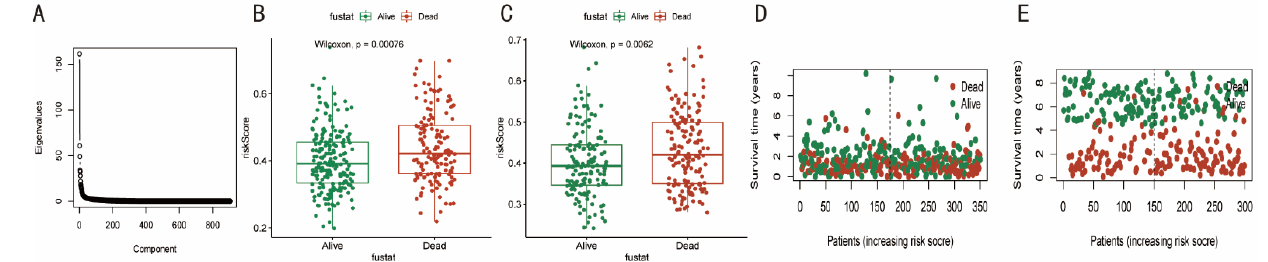
Figure 3. Constructing the pyroptosis-related prognostic model of GC. The PCA method was performed based on all 33 pyroptosis-related genes. ( A ) When the component is beyond four, the eigenvalues decline, leveling off. ( B , C ) In both TCGA and GSE62254 cohorts, the riskScores were significantly higher in patients who died than in those who survived. ( D , E ) In both TCGA and GSE62254 cohorts, the mortality in patients with GC tended to be increased with the higher riskScore.